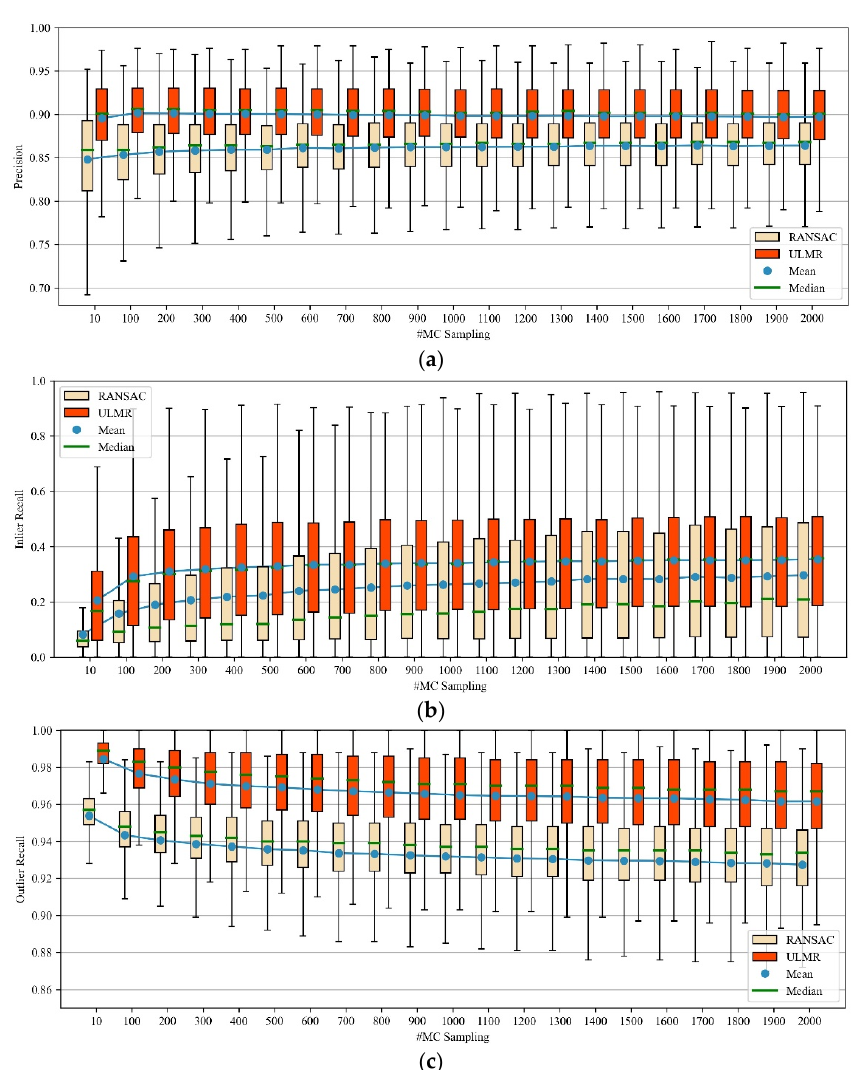
Figure 8. Boxplots of precision, inlier recall, and outlier recall of ULMR and RANSAC. ( a ) Precision; ( b ) inlier recall; ( c ) outlier recall.